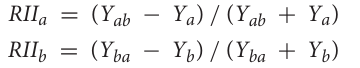
TABLE 1 | Two-way ANOVA results for the effects of interspecific interaction (with or without interspecific interactions) and four hydrological conditions (including 10S, 10F, 30S, and 30F treatments) on growth and morphological data for Scirpus planiculumis and Phragmites australis . Interspecific interaction (I)